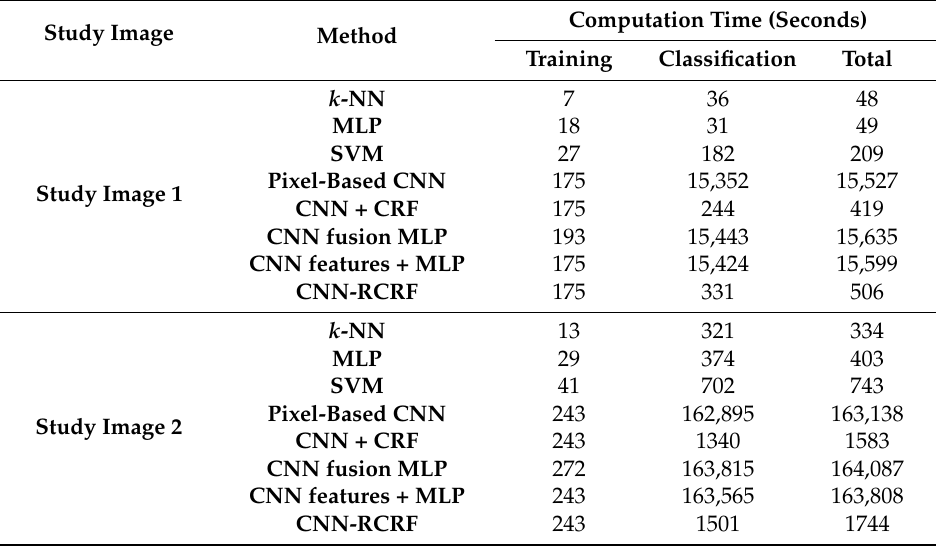
Table 4. Comparison of the computation times of the eight